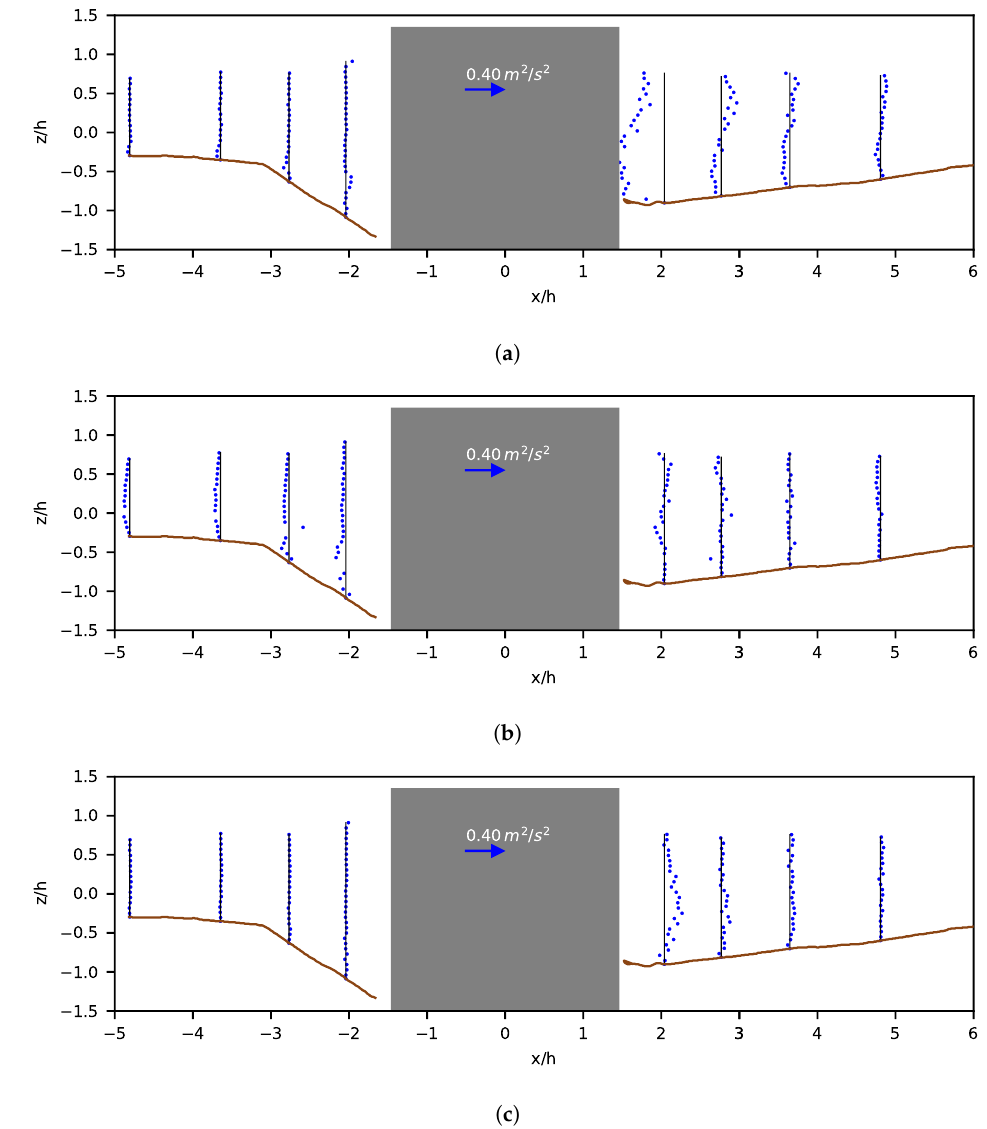
Figure 18. Vertical profiles of the Reynolds shear stresses along the pier’s mid-plane for Exp . 2 U Ebed . ( a ) Reynolds shear stresses ( u (cid:48) v (cid:48) ). ( b ) Reynolds shear stresses ( u (cid:48) w (cid:48) ). ( c ) Reynolds shear stresses ( v (cid:48) w (cid:48)